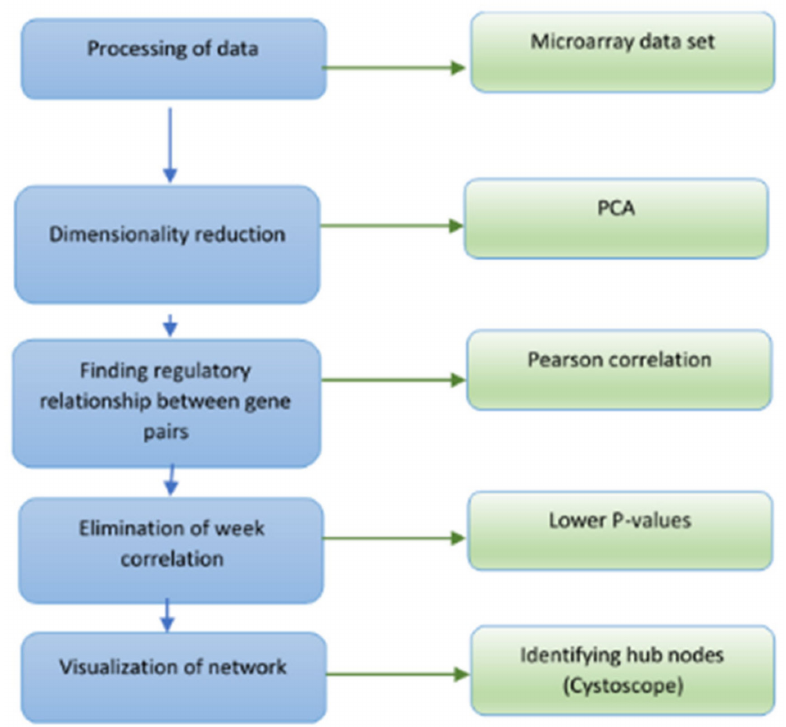
Figure 1. Flow chart of the procedure for gene regulatory network inferencing using the graph-based Pearson correlation